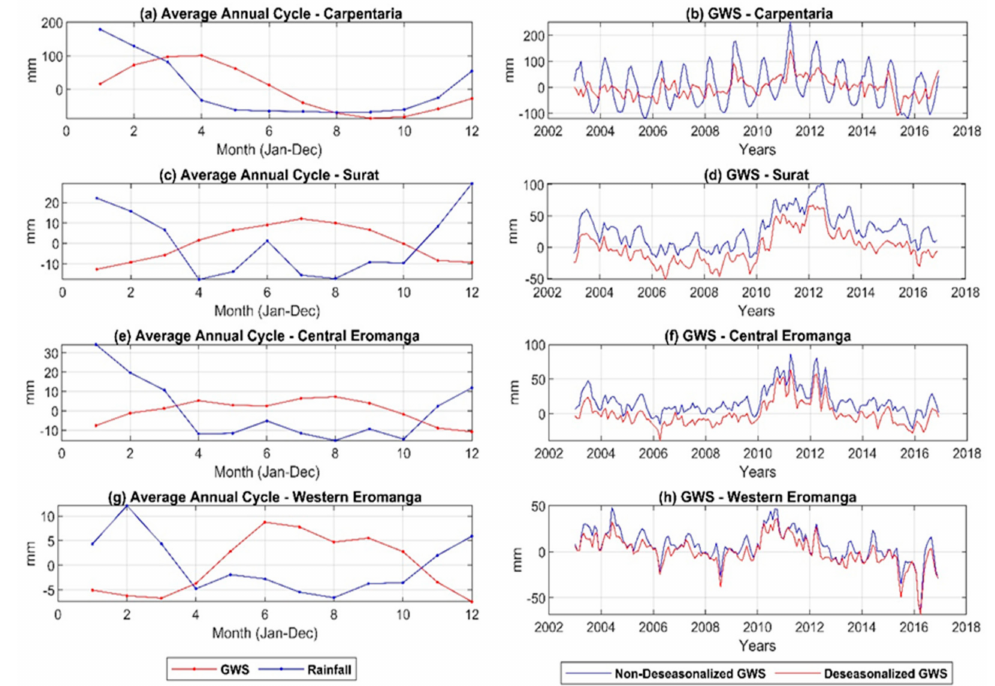
Figure 7. Average annual cycles of GWS and rainfall (column 1) and annual variation in GWS (non- deseasonlized and deseasonlized) (column 2) for Carpentaria, Surat, Central and Western Eromanga sub-basins. Red color indicate GWS and deseasonalized GWS and blue color indicate rainfall and non-deseasonalized